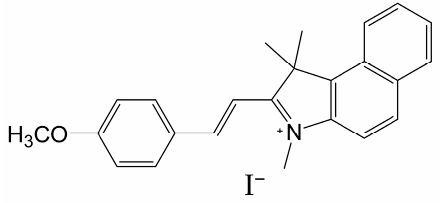
Figure 14. Chemical structure of benzoindolium-based MBI. Table 4. Comparison of the mentioned indolium-based, benzoindolium-based, and benzimidazo- lium-based THz crystals.